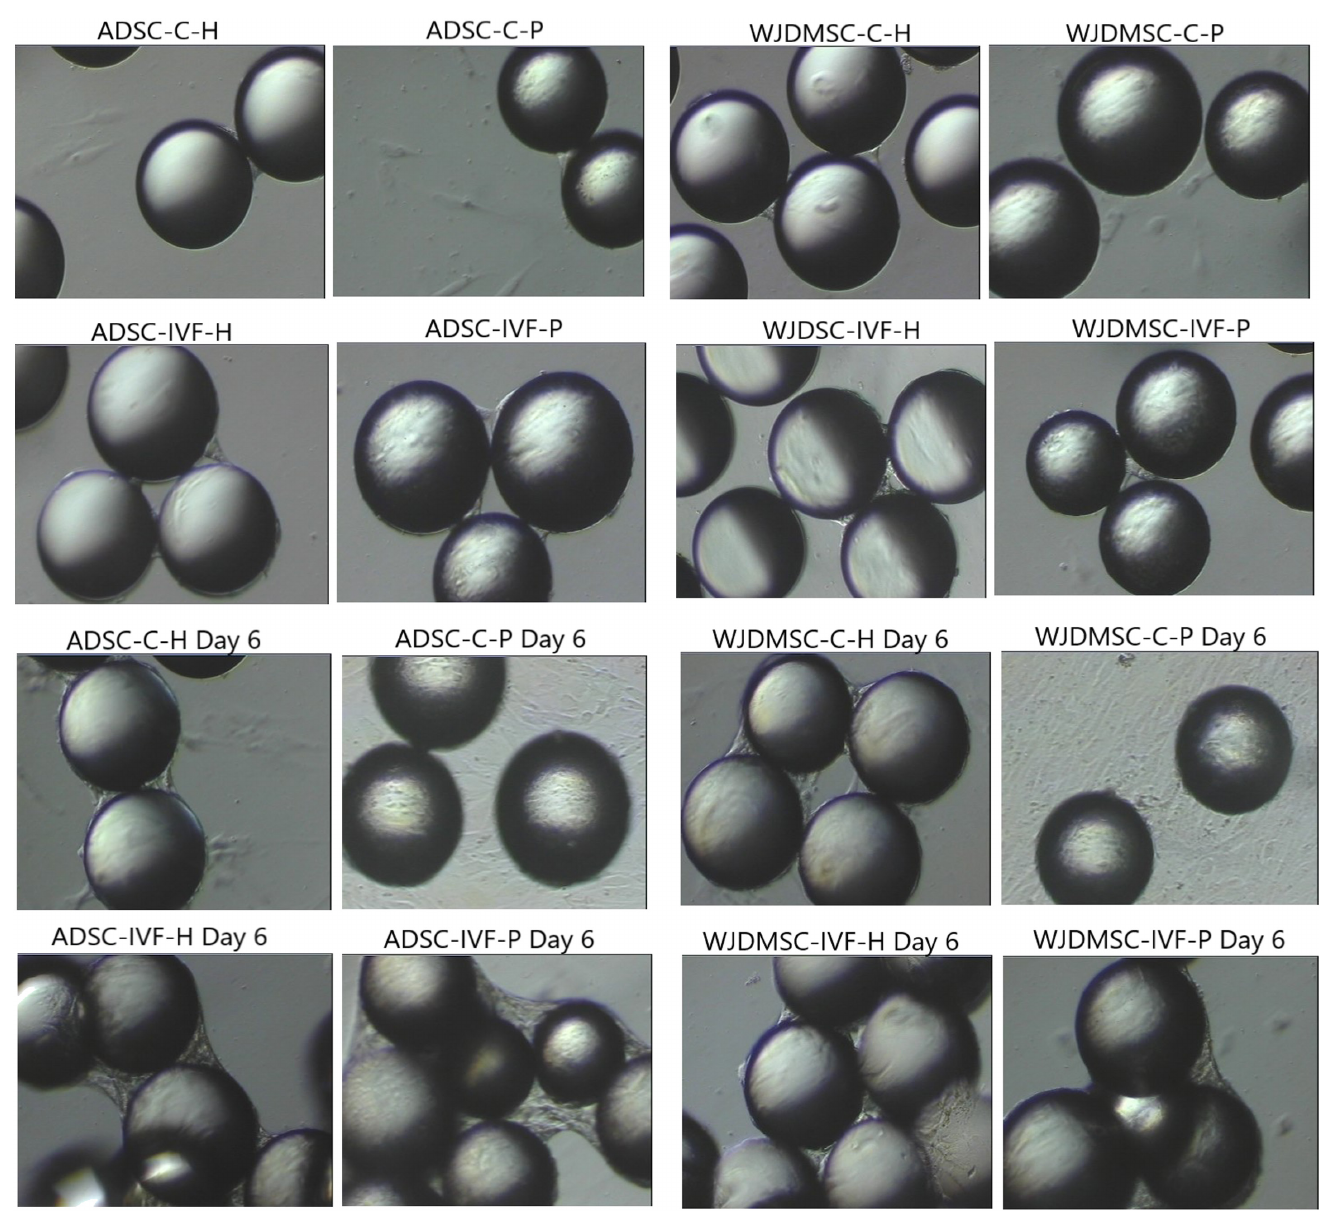
Figure 3. ADSC and WJDSC microcarrier cultivation. ADSC, adipose-derived stem cell; WJDSC, Wharton’s jelly-derived stem